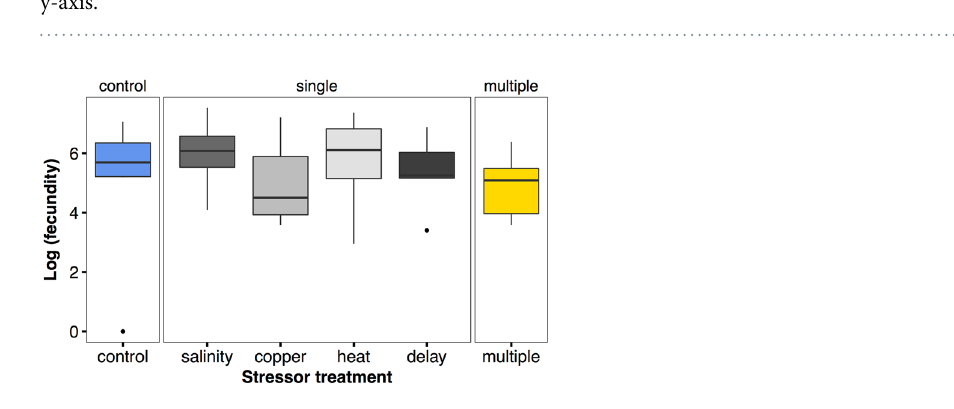
Figure 3. Comparison of control (blue), single stressor (grey), and multiple stressor (yellow) effects on log (fecundity). Boxplots from raw data, treatment effects on x-axis, fecundity on